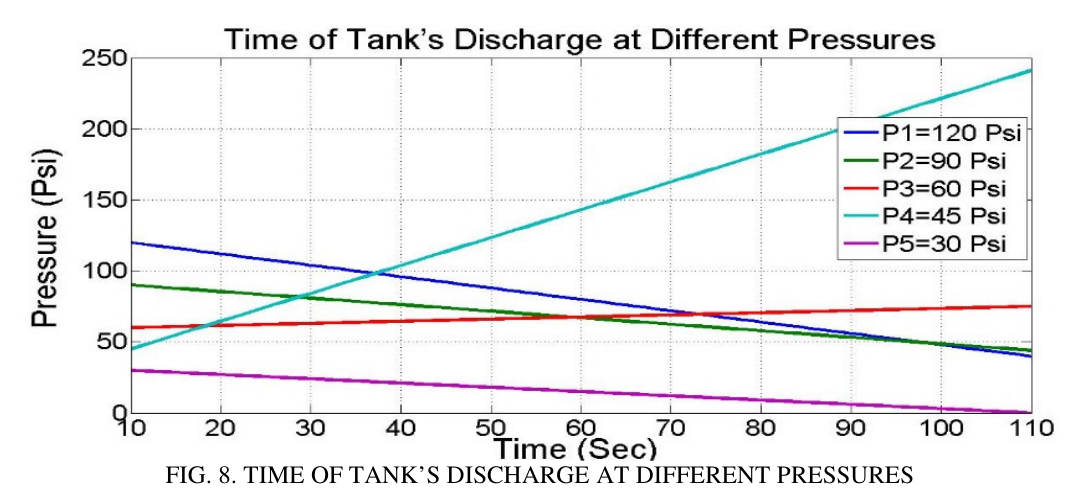
FIG. 8. TIME OF TANK’S DISCHARGE AT DIFFERENT PRESSURES